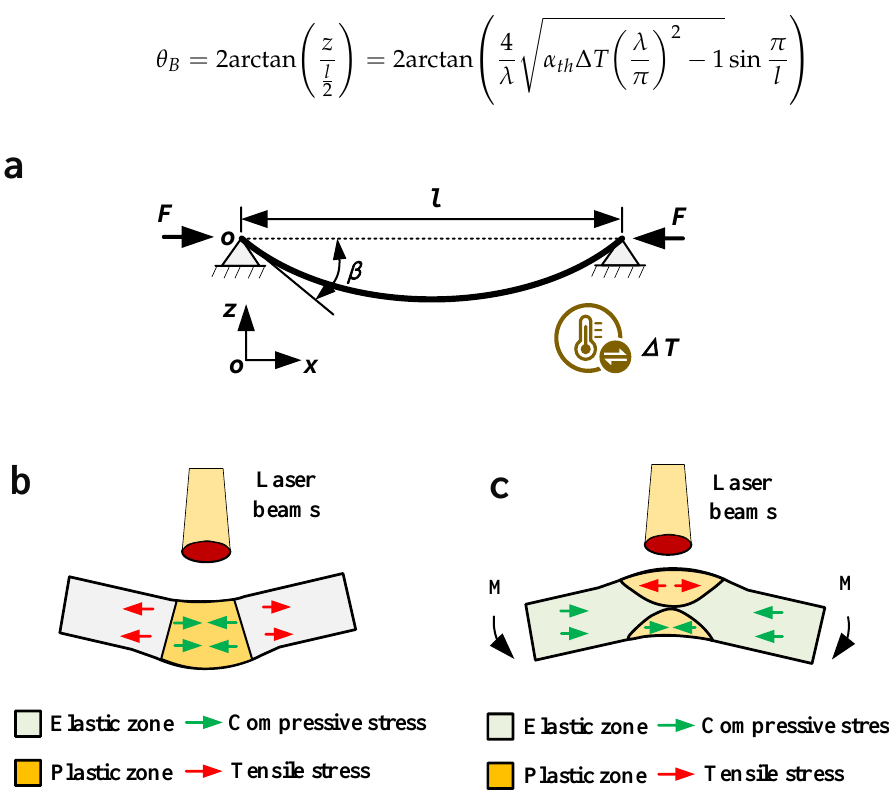
Figure 9. Schematic diagram of thermal buckling about the compression bars and the comparison of the bending deformation about two methods: ( a ) schematic diagram of thermal buckling of hinged compression bars fixed at both ends, ( b ) deformation diagram of the traditional method and ( c ) deformation diagram of BPM.